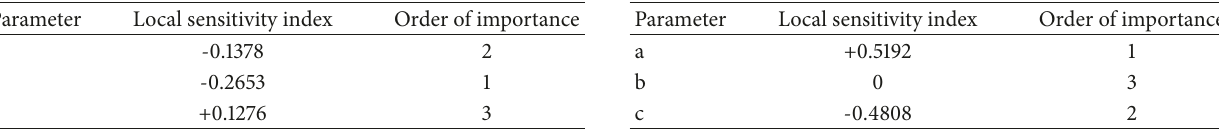
Table 2: Normalized sensitivity indexes and order of importance of 𝑦 ∗ to the three parameters evaluated at the values 𝑎 = 0.9 , 𝑏 = 0.2 , and 𝑐 =